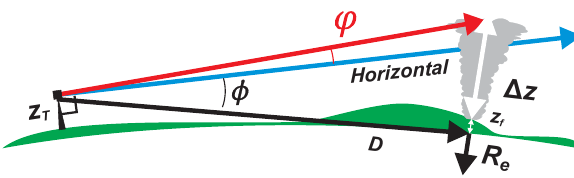
Figure 1. Illustration of the plume height observation ( (cid:49)z ), the tower height ( z T ), the fire height ( z f ), the distance to the fire ( D ), measured inclinometer angle ( ϕ ), and horizon angle ( φ , accounting for the curvature of the Earth with radius = R E ).